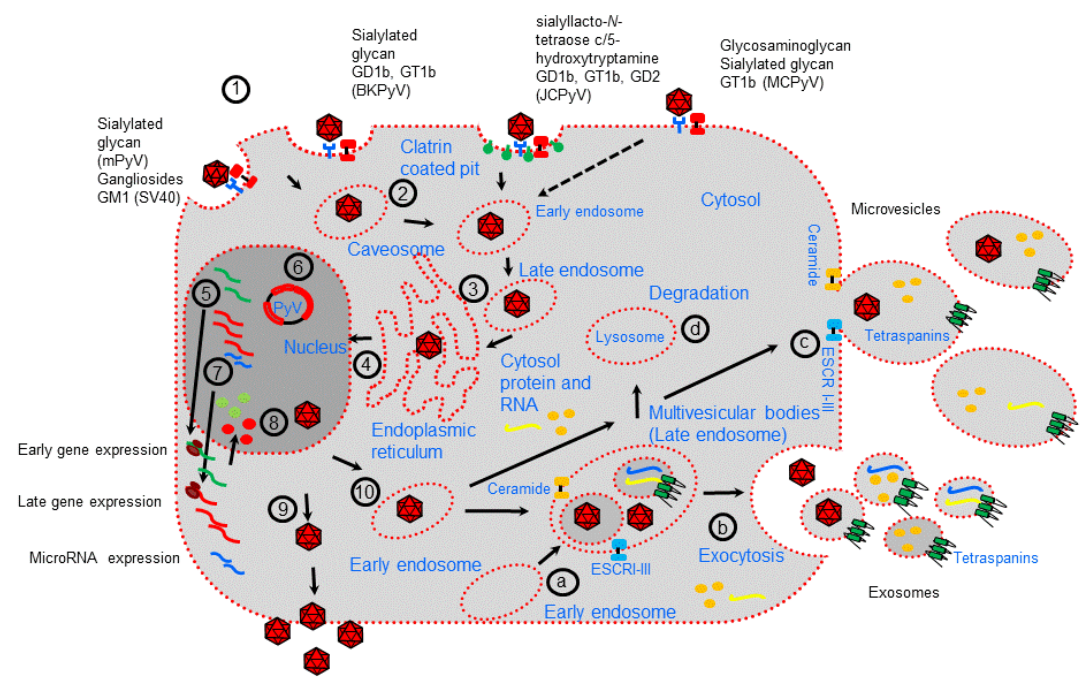
Figure 1. Polyomavirus life cycle and extracellular vesicle formation. Polyomavirus (PyV) infection starts with receptor-mediated interactions with specific receptors ( 1 ). Then, receptor-mediated endocytosis occurs mainly by internalization through caveosomes that tra ffi c through the cytoplasm using a microtubule network to the late endosome before being delivered to the endoplasmic reticulum (ER) ( 2 – 3 ). JCPyV is internalized through clathrin-coated vesicles. In the ER, virions benefit from chaperones, disulfide isomerases, and reductases, which facilitate partial capsid uncoating ( 3 ). The viral genome is then transported into the nucleus via the nuclear pore complex ( 4 ). Expression of early genes occurs, and the proteins are translocated into the nucleus, where they serve to initiate viral DNA replication ( 5 – 6 ). Late genes are then expressed ( 7 ). Late proteins are translocated into the nucleus, where they self-assemble to form capsids into which newly synthetized viral DNA is packaged ( 8 ). During viral expression, PyVs also encode microRNAs involved in the regulation of early viral gene expression and target host factors. Progeny virions are mainly released from infected cells after cell lysis ( 9 ). However, a small fraction of progeny virions may also be released into the extracellular environment through nonlytic egress, which depends on the cellular secretion pathway generating extracellular vesicles ( 10 ). EVs are formed either ( a – b ) as early endosomes that accumulate intraluminal vesicles within the lumen of multivesicular bodies (MVBs) that fuse with the plasma membrane to release exosomes or ( c ) by budding of the plasma membrane (microvesicles). Early endosomes can fuse with lysosome to fulfill the degradation pathway ( d